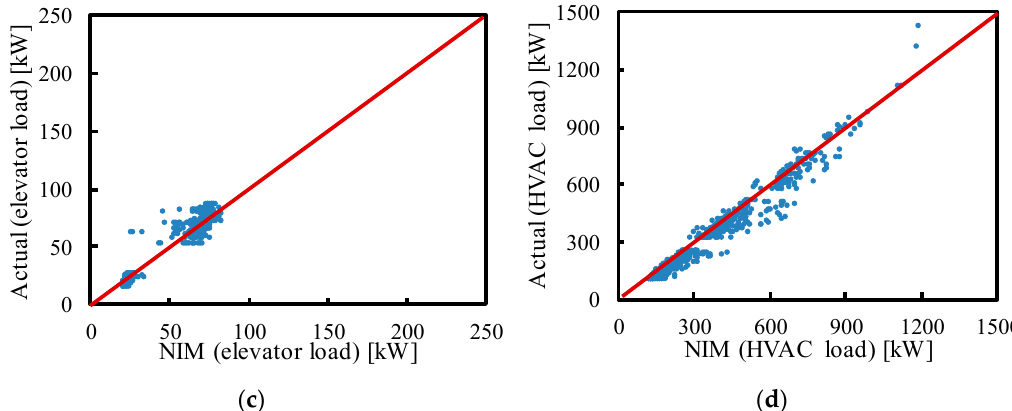
Figure 5. Testing results of the NIM model based on Approach I: ( a ) the comparison results of lighting system load; ( b ) the comparison results of plug-in system load; ( c ) the comparison results of elevator system load; ( d ) the comparison results of HVAC system load.